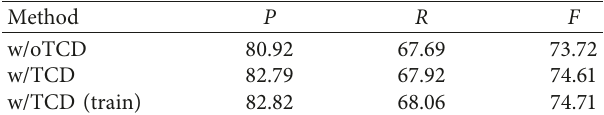
Table 6: Function of text center direction.